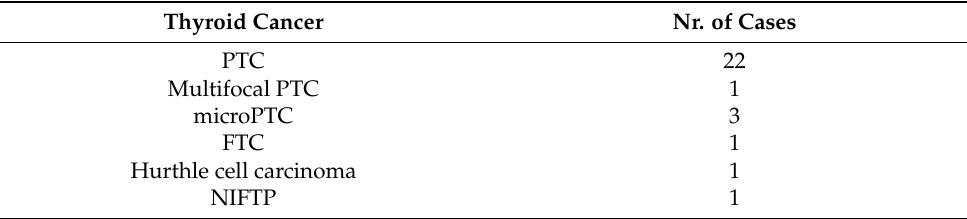
Table 2. Distribution of malignancies in the analyzed group.